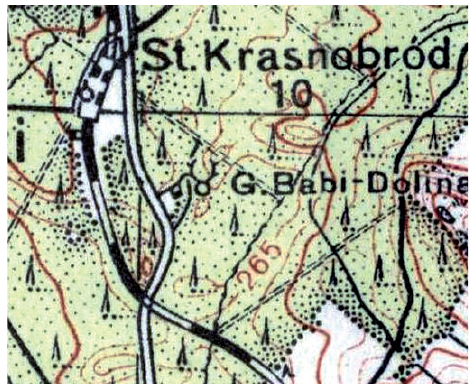
Fig. 4. An example of learning a map – the Babi Dolina gamekeeper’s cottage on the WIG map (1:100,000 Tactical map of Poland P46_S36_Zamość, 1938) is not located topographically as one might read it. The signature refers to buildings depicted on the left.